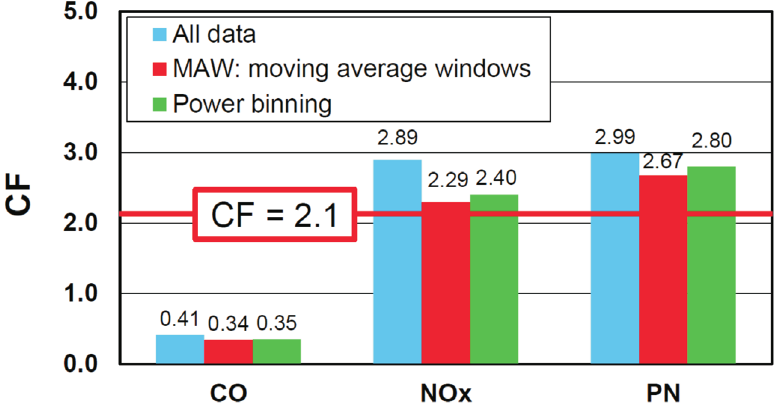
Fig. 14. Conformity factors of carbon monoxide, nitrogen oxides and particle number emissions from tests employing different methods of processing results (diesel